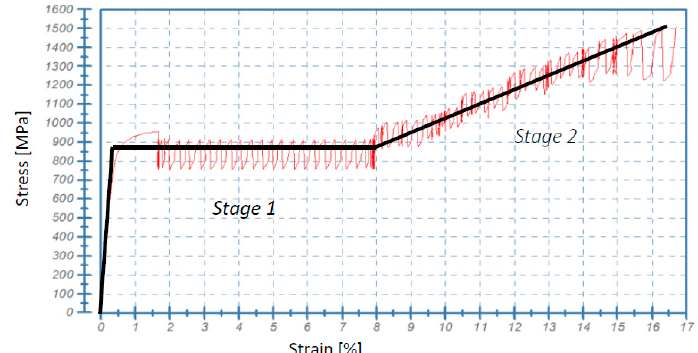
Figure 14. Identification of parameters of the constitutive model for grade 316L stainless steel (cf. Table 1) at 4.2 K (Stage I: no hardening, Stage II: linear hardening).